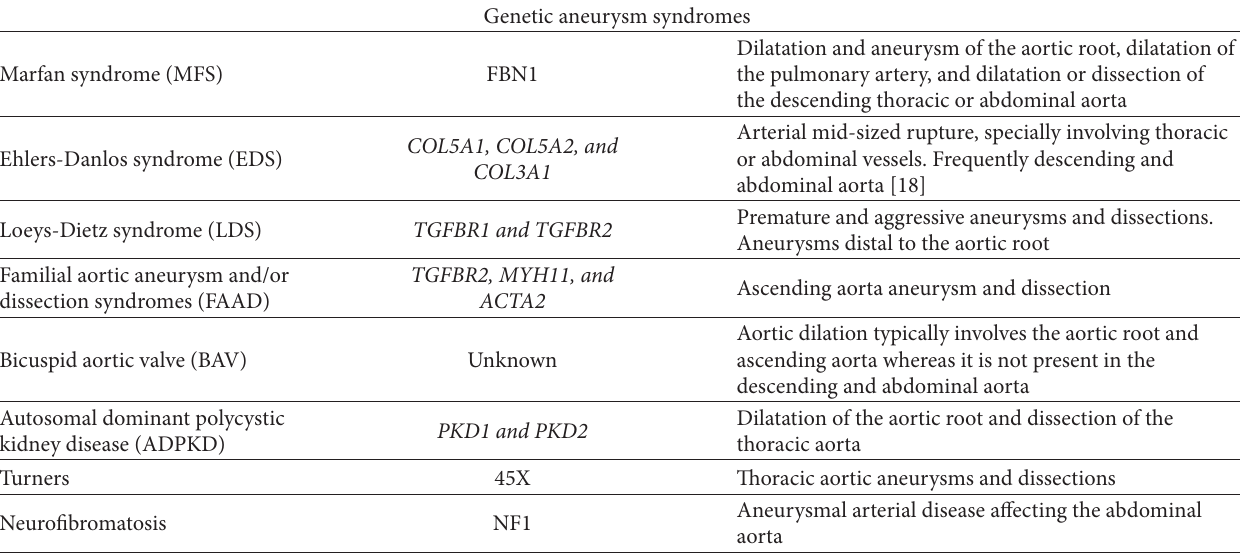
T 1: Aneurysm syndromes.